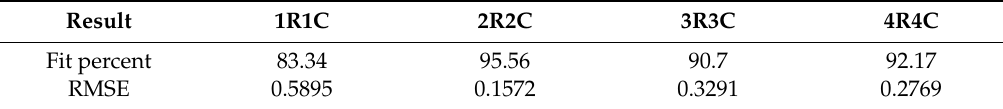
Table 11. Thirty-minute prediction results for experiment C.